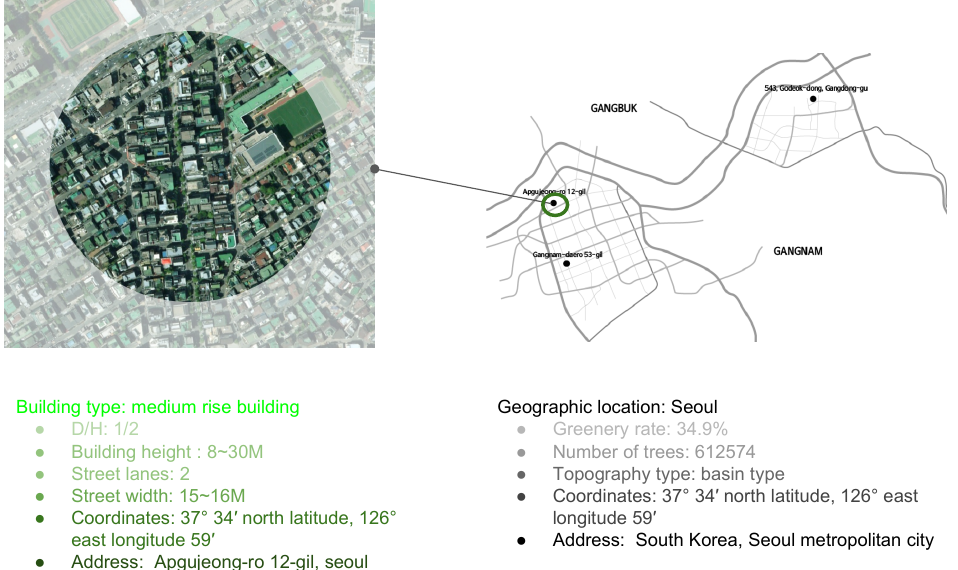
Figure 5. Case study’s geographic location and targeted zone area to apply the developed tool on its pedestrian pathway.